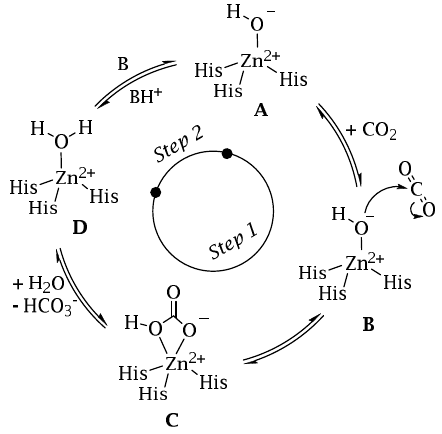
Figure 2. CA catalytic mechanism schematically represented for a α-class isoform.